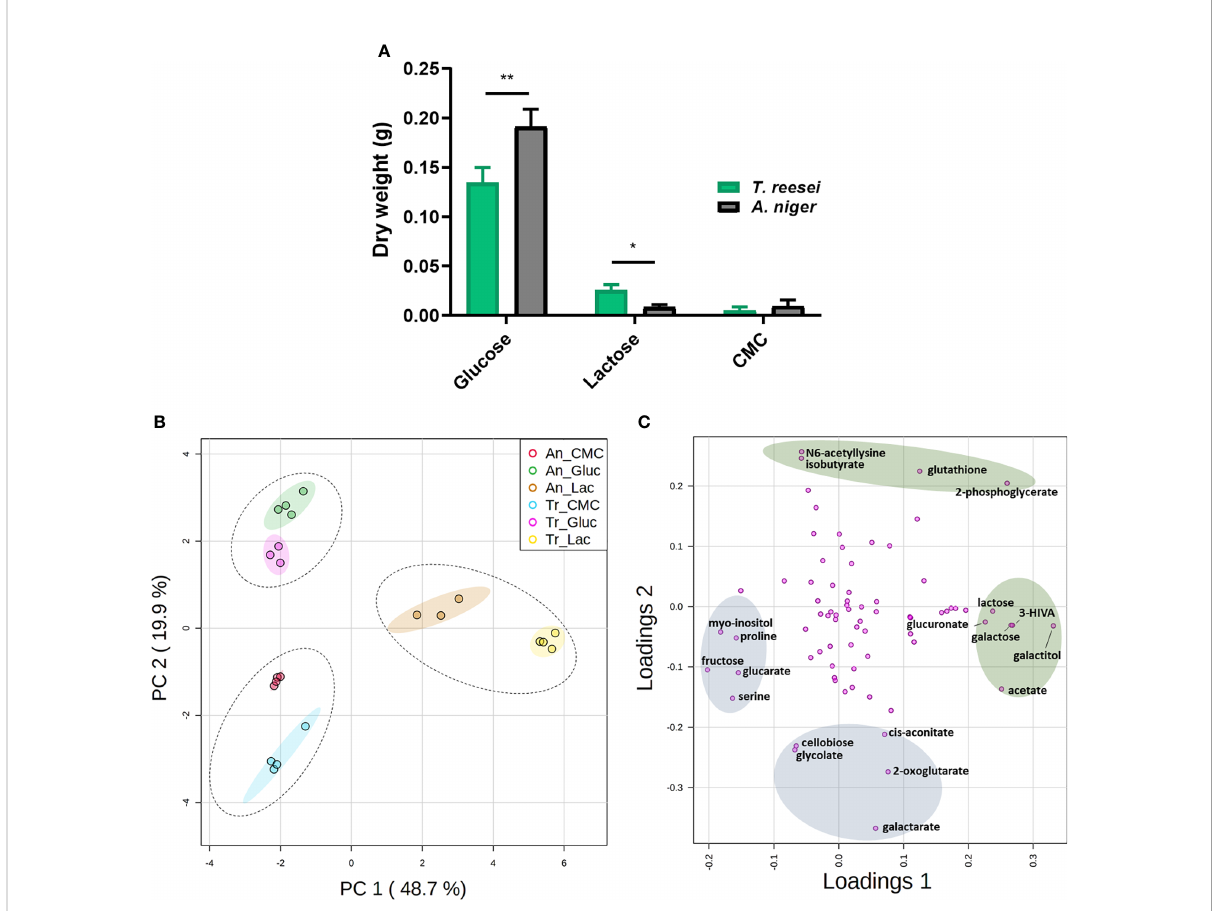
FIGURE 1 Mycelial growth and PCA analysis of the metabolome of T. reesei (Tr) and A. niger (An) grown on glucose (Gluc), lactose (Lac), and CMC for 48 h. (A) Dry weight of mycelia. The statistical difference between both fungi for the same condition was determined by the two-tailed unpaired Student t-test (P-value: * < 0.05; ** < 0.01). (B) Principal components 1 and 2 (68.6% of total variance) of fungi grown on glucose, CMC, and lactose. Dotted and solid ellipses show the three large groups formed and regions with more than 95% of reliability, respectively. (C) PCA loading plot of the metabolites responsible for the observed variation in T. reesei and A. niger . Only metabolites with the highest scores are named. The metabolites highlighted in green and blue show the highest and lowest score values for the fi rst and second components, respectively. 3-HIVA,